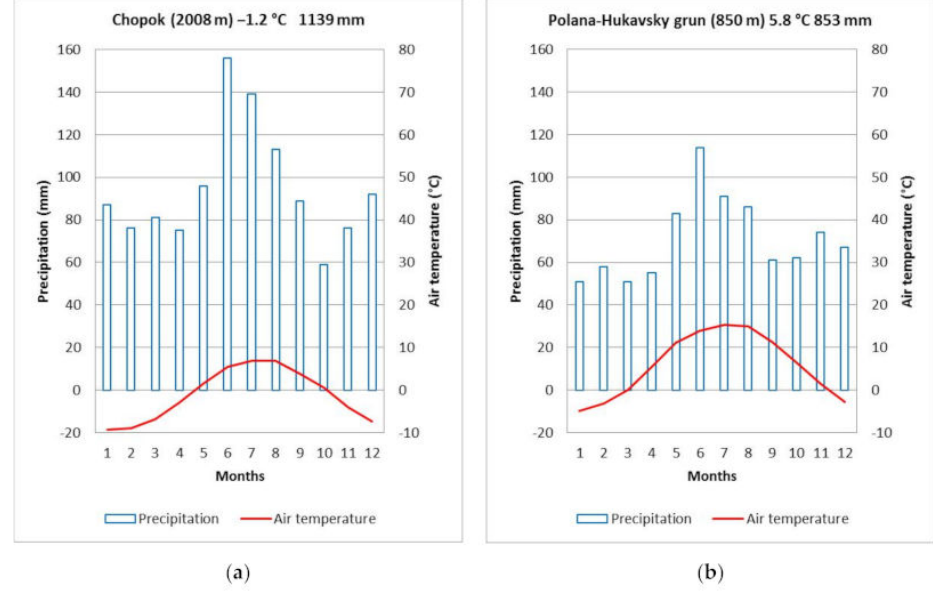
Figure 2. Climate diagrams for ( a ) Chopok and ( b ) Polana-Hukavsky